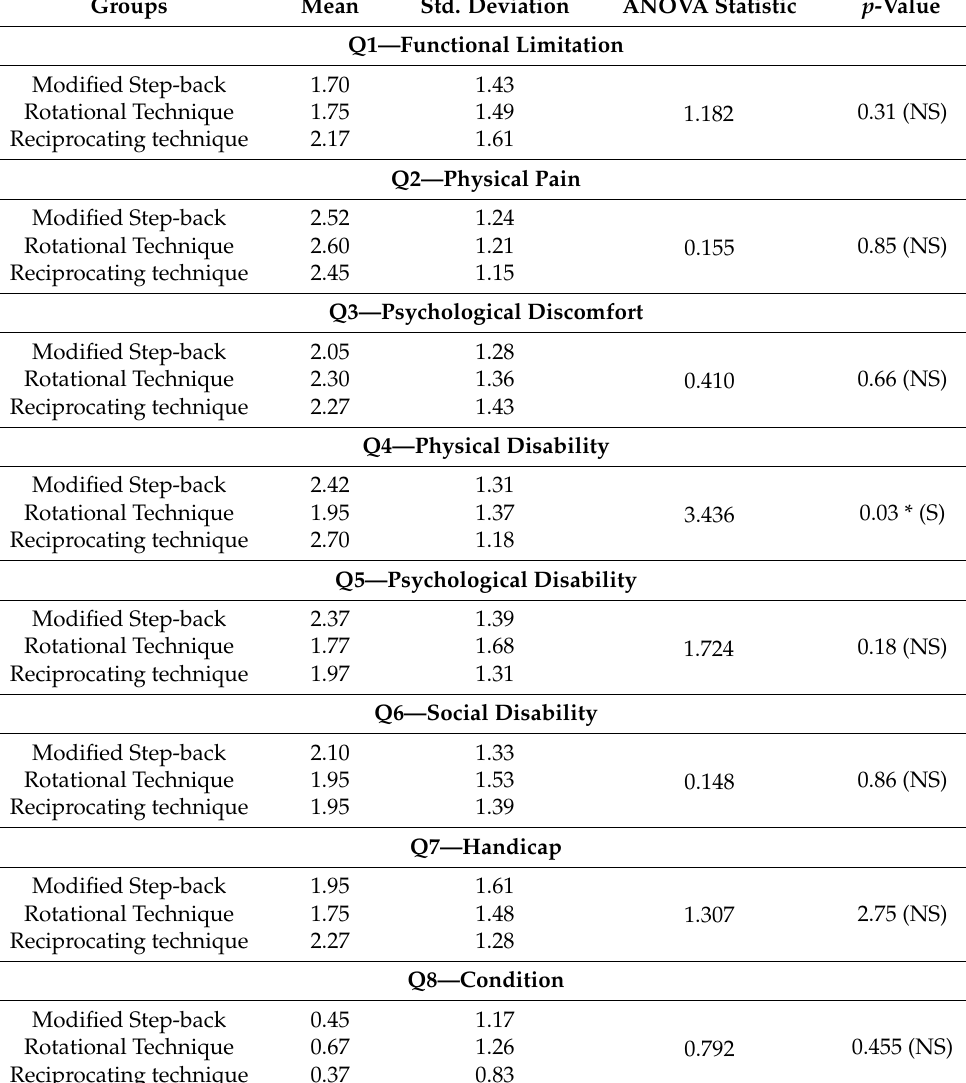
Table 1. Comparative evaluation of quality of life before treatment.